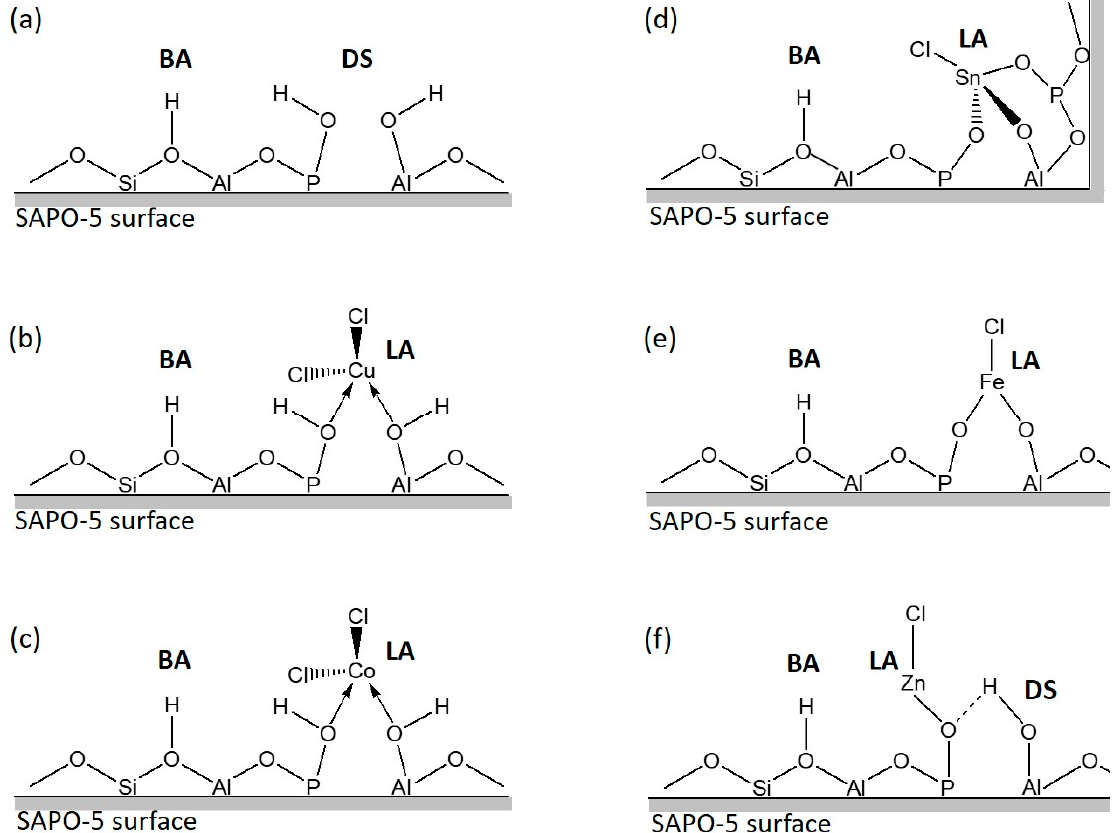
Figure 4. Possible structures of ( a ) SAPO-5, ( b ) CuCl x /SAPO-5, ( c ) CoCl x /SAPO-5, ( d ) SnCl x /SAPO-5, ( e ) FeCl x /SAPO-5 and ( f ) ZnCl x /SAPO-5 where the Br ӧ nsted acid, Lewis acid and defect sites are denoted as BA, LA and DS, respectively. The arrow and dot line represent the dative and hydrogen bondings, respectively.